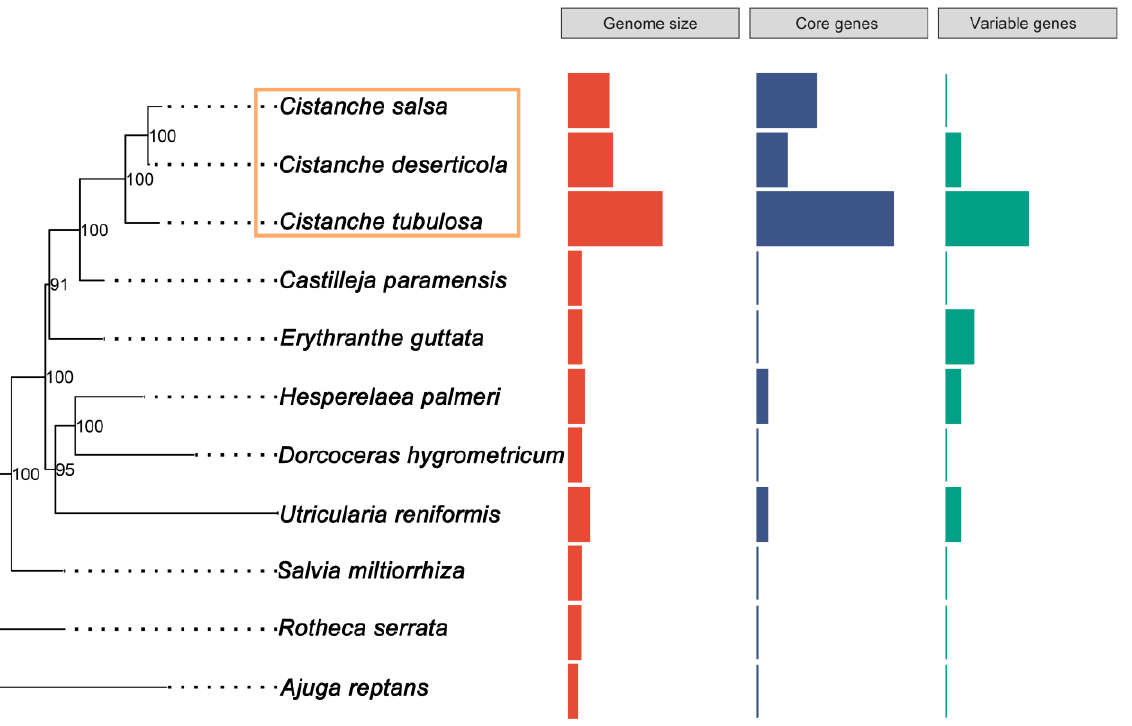
Figure 1. Genome size and protein-coding-gene contents among 11 Lamiales species mitogenomes.